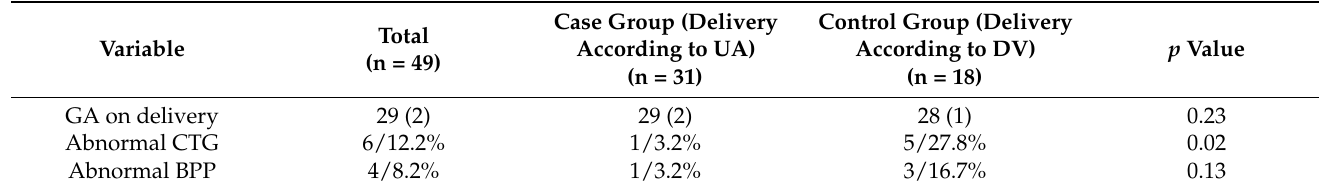
Table 6. Descriptive statistics of confounding variables among 45 infants born under 30 weeks of gestation.